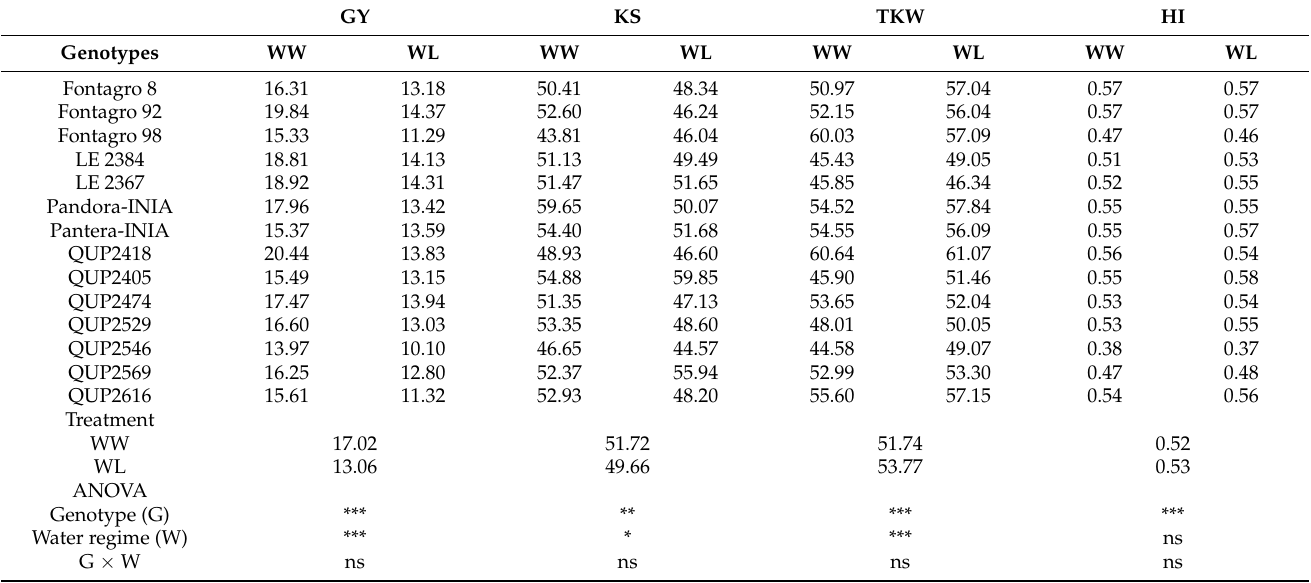
Table 3. Mean values of grain yield (GY; g per plant), number of kernels per spike (KS), thousand- kernel weight (TKW; g) and harvest index (HI) for fourteen genotypes grown under water-limited (WL) and well-watered (WW) regimes in glasshouse conditions. Significance levels for the analysis of variance (ANOVA) are also shown.